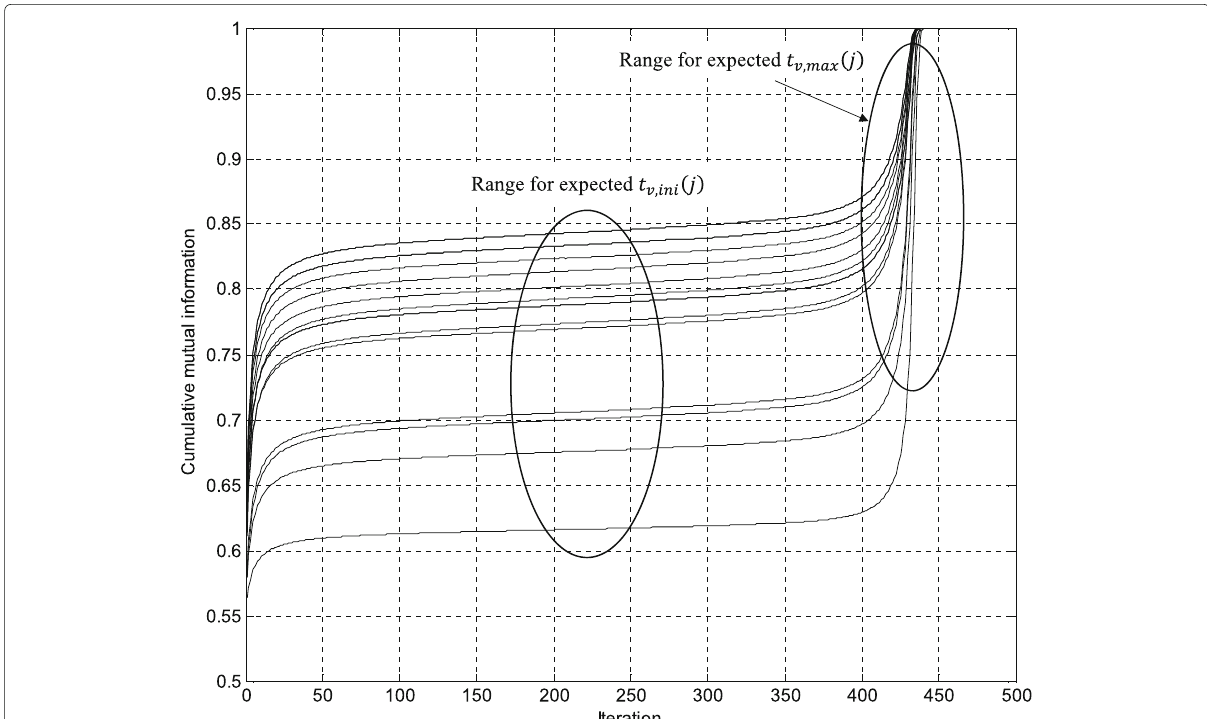
Fig. 4 Cumulative mutual information as a function of the number of iterations for each type of variable node when a rate-1/2 LDPC code specified in IEEE 802.11ad is